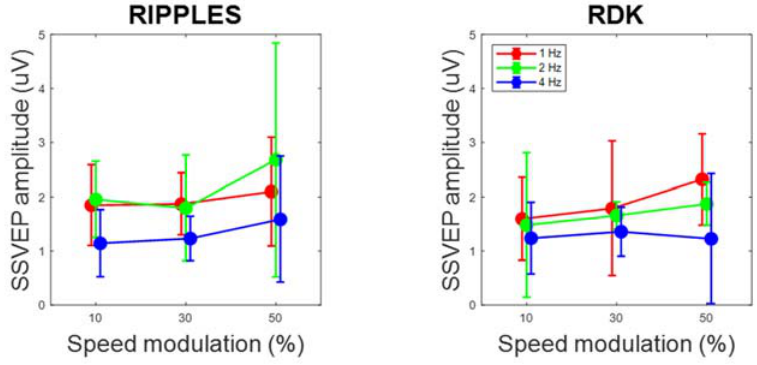
Figure 4. Steady-state visual evoked potential (SSVEP) amplitude as a function of speed modulation amplitude and frequency, shown separately for Ripples and RDK videos. Data have been averaged across participants. Error bars are 95% confidence intervals. Table 2. Results of the GLMM analysis of SSVEP amplitude.